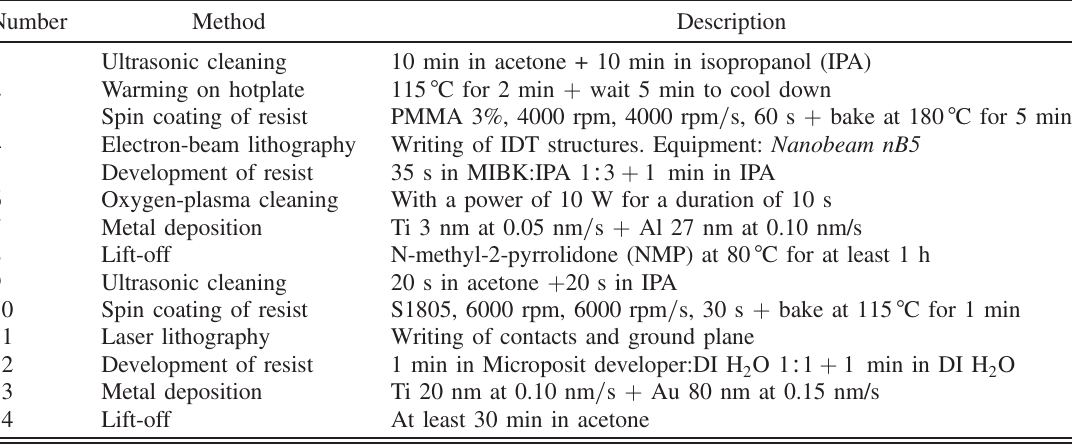
TABLE I. Fabrication